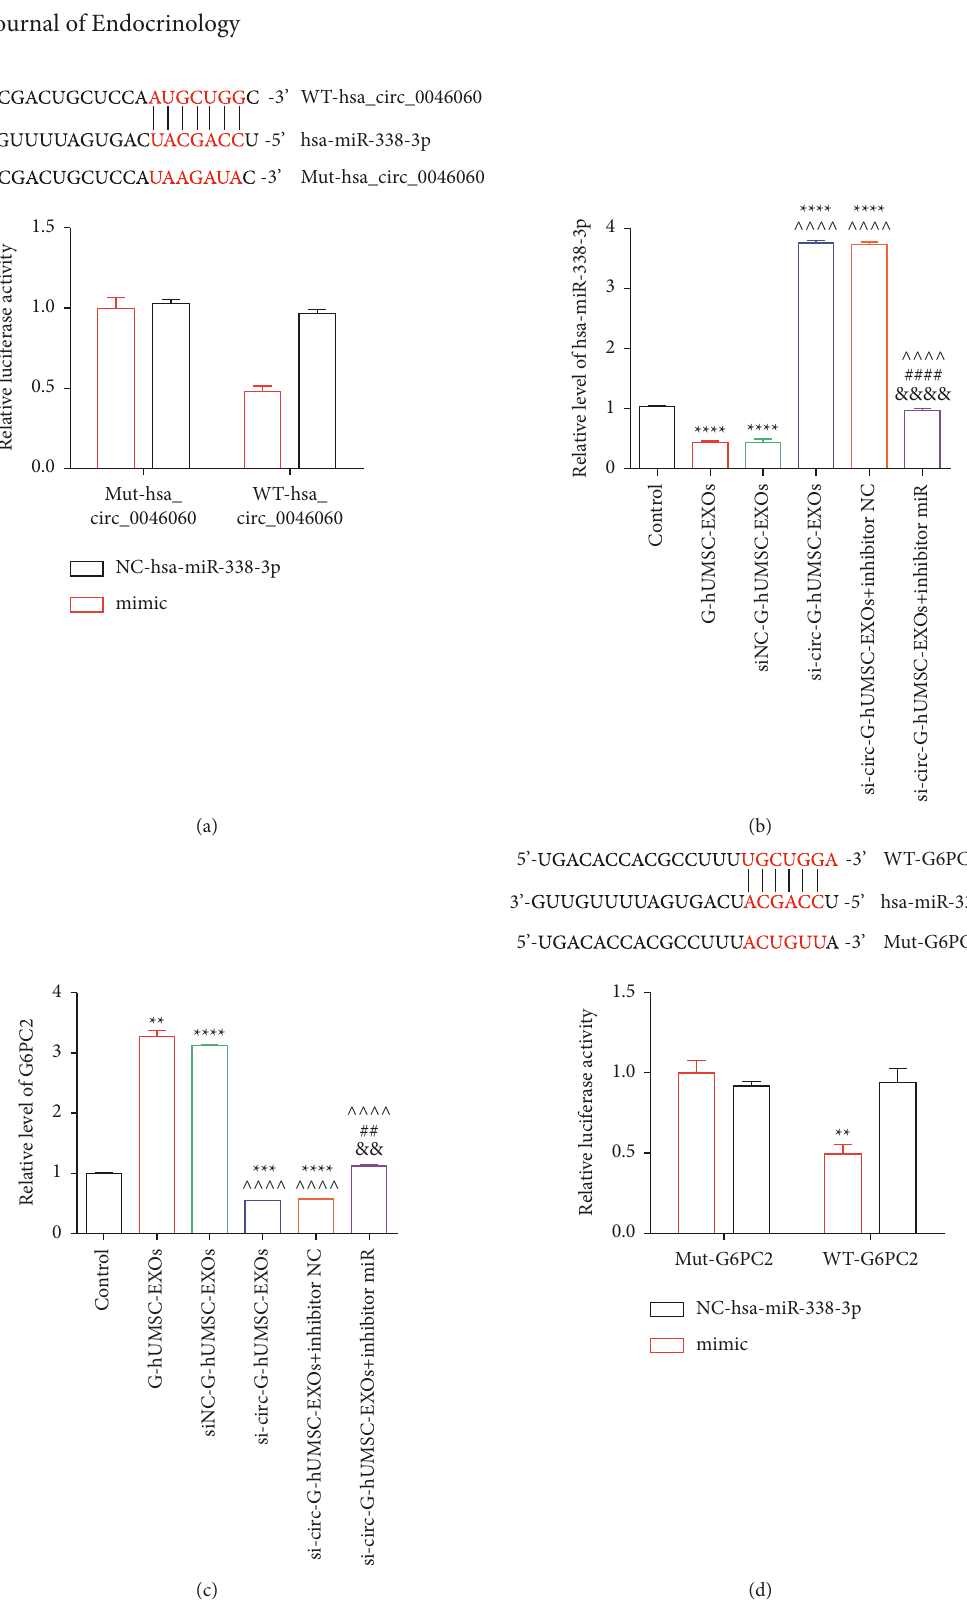
(d) hsa-miR-338-3p targets the 3 G6PC2 and hsa-miR-338-3p in L-02 cells.